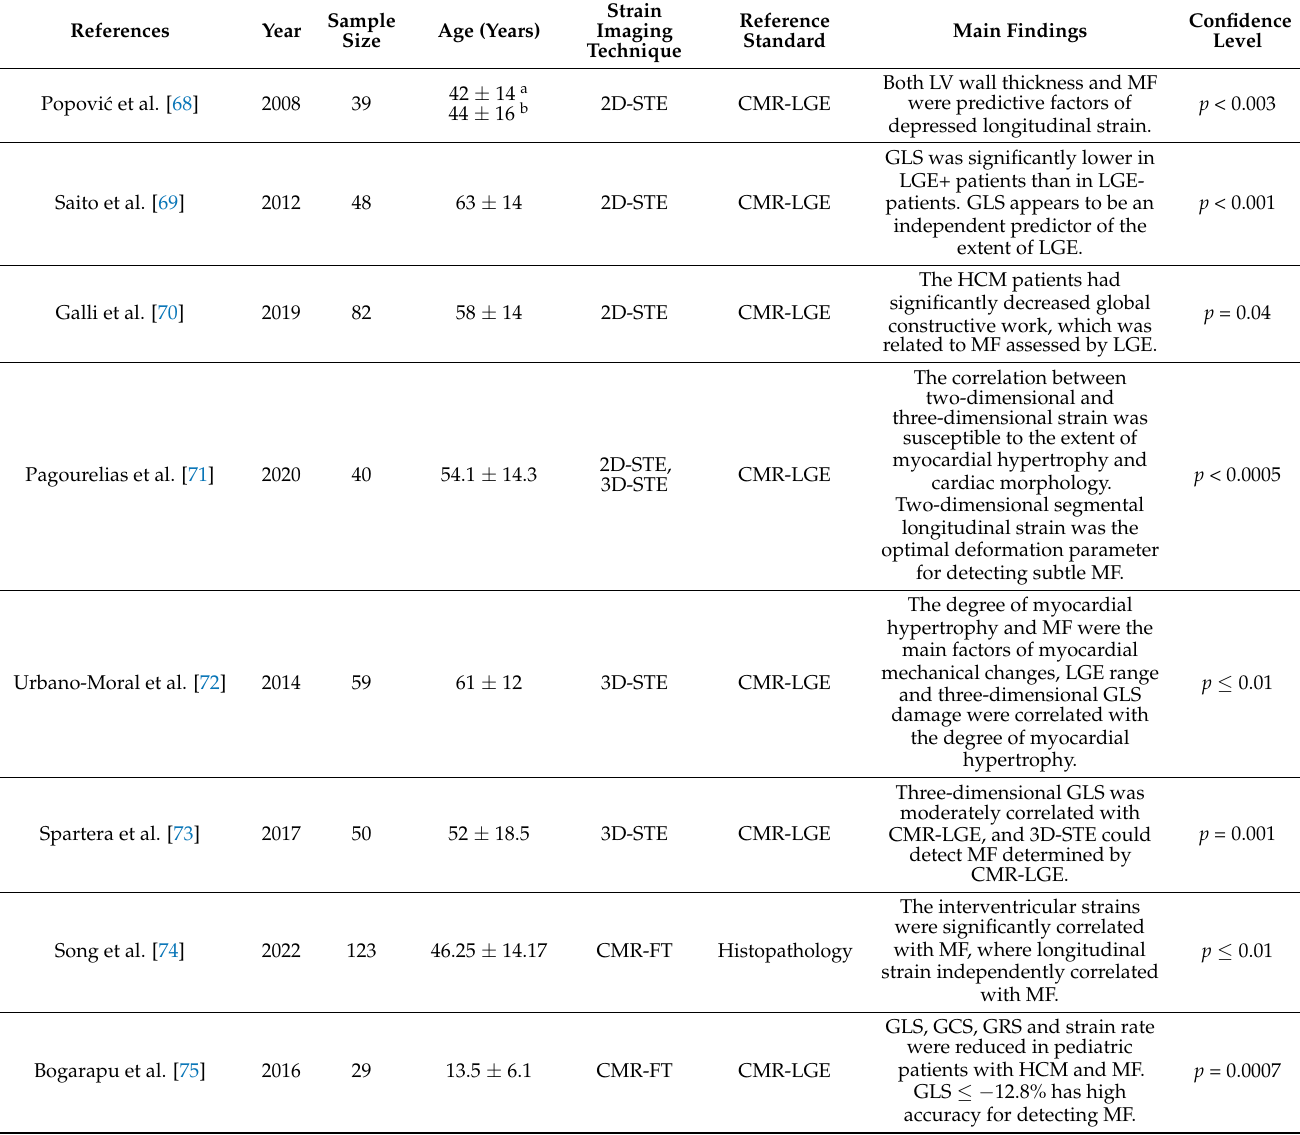
Table 3. Evaluation of MF in HCM patients using strain